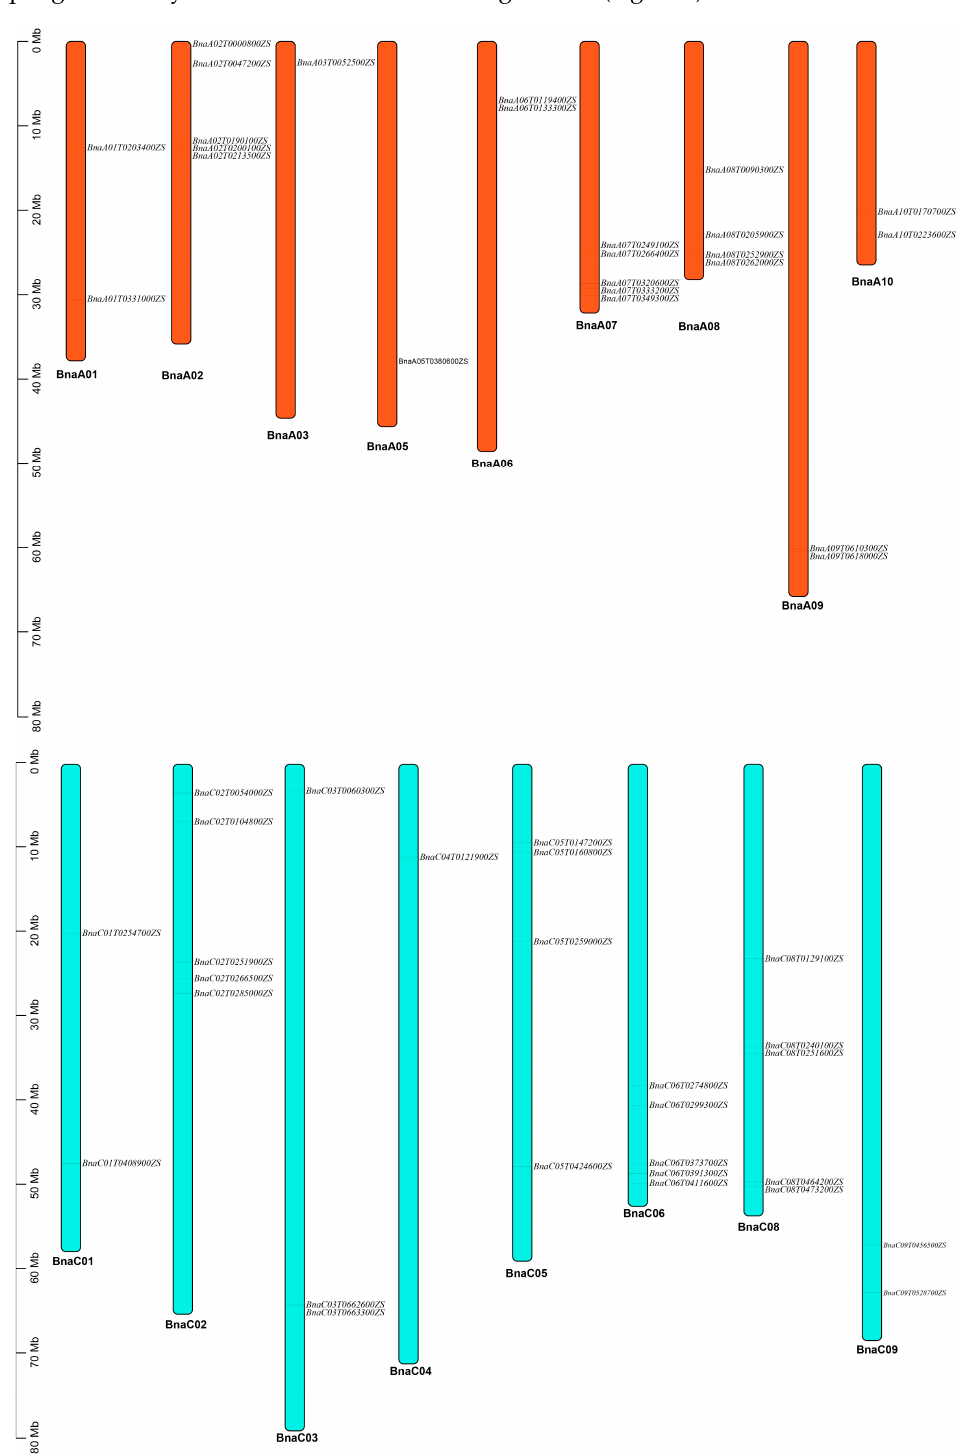
Figure 3. Chromosomal mapping of 51 BnaJAZs . The length of the chromosome is represented in Mb. The chromosome number is presented on the bottom of each chromosome, and the names of BnaJAZs were at their